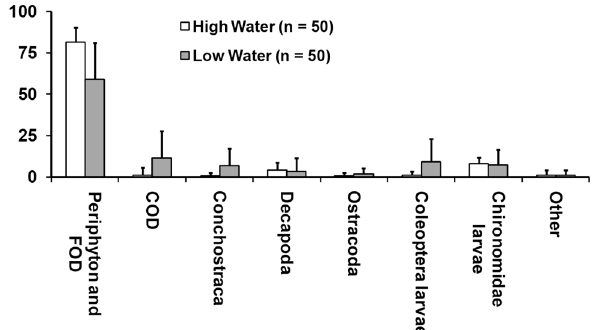
Fig. 5. Seasonal changes in the proportional composition of food items within stomachs of Symphysodon haraldi from blackwater habitats of the Tefé region. Calculations of mean food item contribution excluded specimens with empty stom - achs. Error bars (displayed above bars) refer to one standard deviation from mean. Algae = periphyton identified as a mass detritus. GPM = green plant (macrophytes) matter –